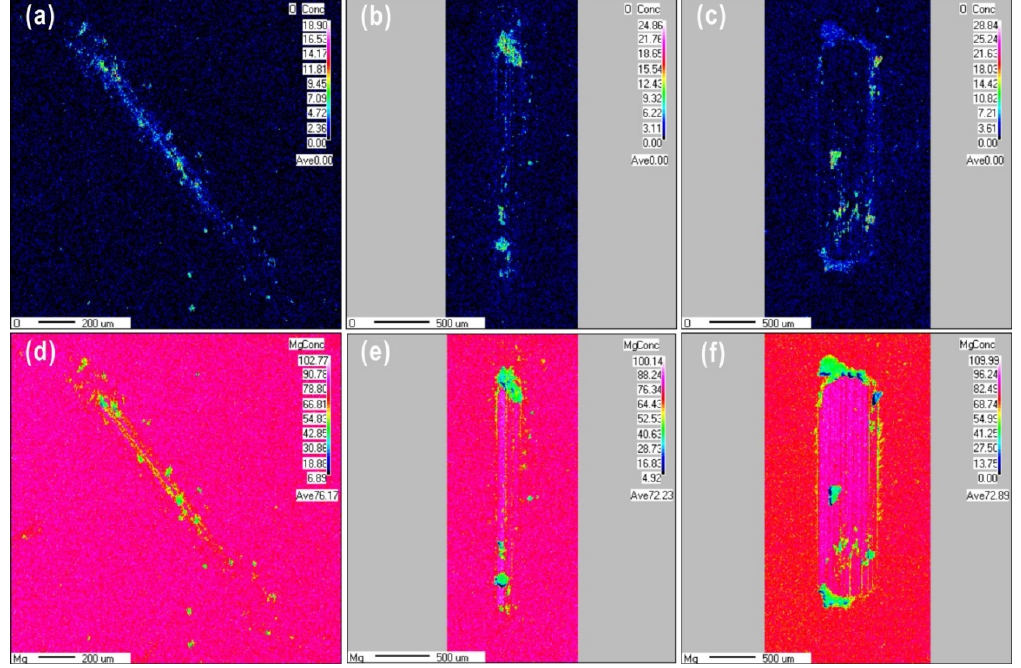
Figure 4. EPMA maps of O and Mg after reciprocating sliding friction for 100 cycles at different loads ( a , d ) 0.1 N, ( b , e ) 1 N, and ( c , f ) 10 N.